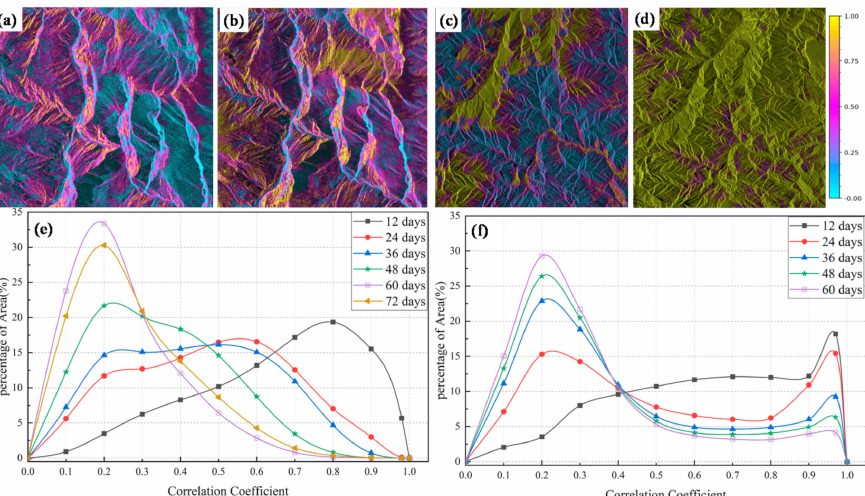
Figure 18. ( a , b ) The correlation coefficient graphs generated by Sentinel-1 data in the same area, Garze Prefecture, respectively, at a summer interval of 48 days and the ALOS-2 data generated at a summer interval of 168 days, without filter processing; ( c , d ) correlation coefficient graphs obtained in the same area, the Ya’an city area, using the same filtering method and filtering window. The data are generated at 364-day interval of Sentinel-1 data and 12-day interval of ALSO-2 data in summer; ( e ) the picture shows the selected area ( a ) in which we used Sentinel-1 data to obtain the coherence statistics graph of different intervals of 7 May 2018~18 July 2018; ( f ) the picture shows the selected area ( c ) in which we used Sentinel-1 data to obtain the coherence statistics graph of different intervals between 10 November 2018 and 21 January